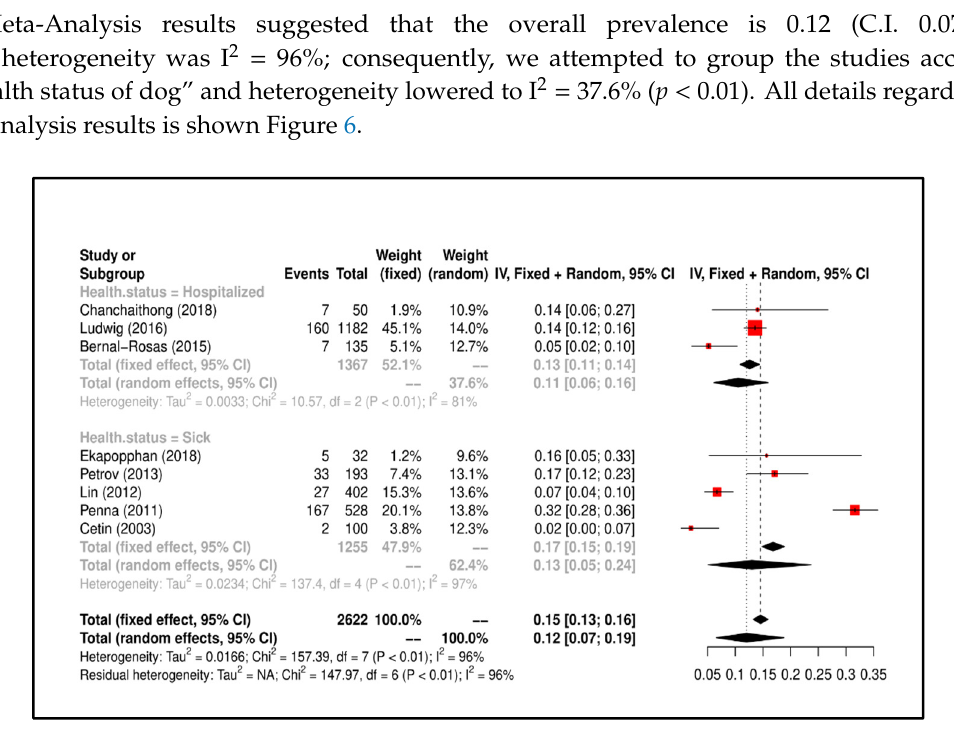
Table 6. Data of the included articles regarding the presence of Pseudomonas aeruginosa in dogs.